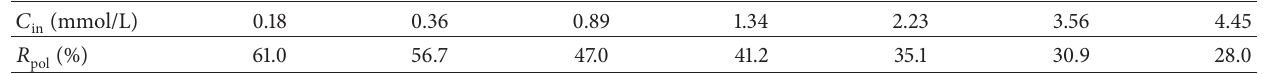
and 𝐶 for removal of PIIs (PSSNa-Cd) [20, 23, 27, pol in